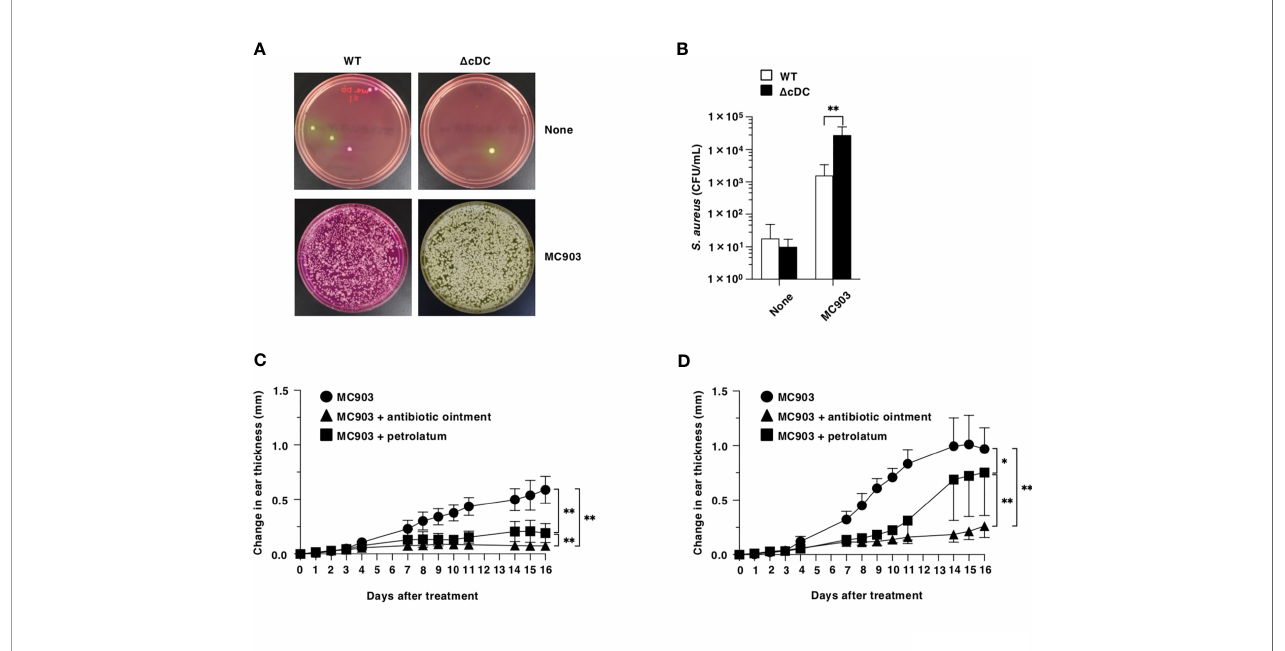
FIGURE 6 | Constitutive loss of cDCs accelerates the colonization of S. aureus and the disruption of barrier function in eczematous skin. (A, B) Quanti fi cation of S. aureus cultured from the homogenates of ear skin of WT mice and D CD11c hi cDC mice (n = 7 per group) at days 0 and 16 after topical application with MC903. (A) Representative pictures of Mannitol salt agar with egg yolk plates at days 0 (None) and 16 (MC903). (B) CFU of S. aureus at days 0 (None) and 16 (MC903) after topical application with MC903. ** P <.01 compared with WT mice by two-sided paired student t -test. (C, D) WT mice (C) and D CD11c hi cDC mice (D) (n = 6 per group) were treated topically with MC903 in combination with or without antibiotic ointment or petrolatum on the left ear skin. Ear thickness was evaluated for 16 days. Data are obtained from seven individual samples in a single experiment. * P < .05, ** P < .01 compared with MC903-treated group or among groups. All data are representative of at least 3 independent experiments by two-way